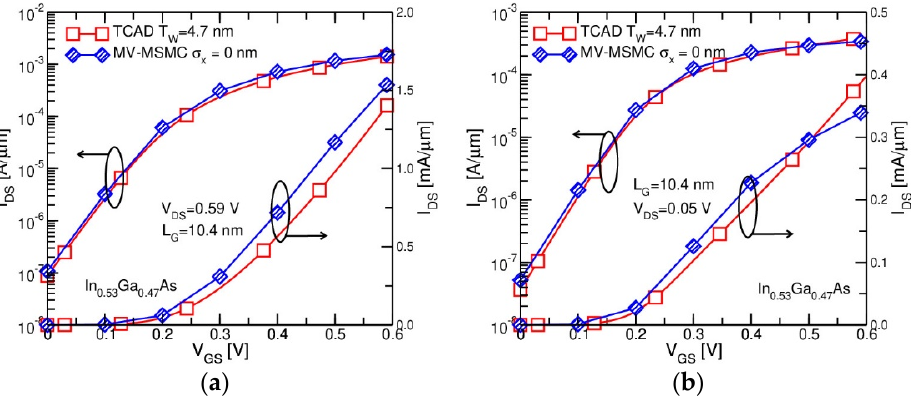
Figure 12. I DS -V GS comparison between TCAD (squares) and MV–MSMC (diamonds) for V DS of ( a ) 0.59 V and ( b ) 50 mV. Device with L G = 10.4 nm, sketched in Figure 4. Table 3. Main model parameters of the QDD.